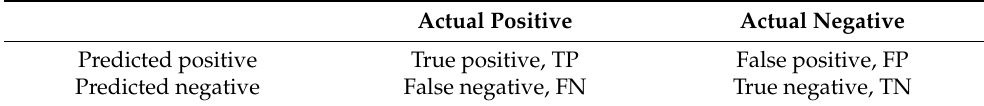
Table 3. Confusion matrix. When the data label is positive and the forecast is also positive, it is called the true positive. When the data label is negative and the forecast is positive, it is called the false positive. When the data label is positive and the forecast is negative, it is called the false negative. When the data label is negative and the forecast is also negative, it is called the true negative. Actual Positive Actual Negative Predicted positive True positive, TP False positive, FP Predicted negative False negative, FN True negative,